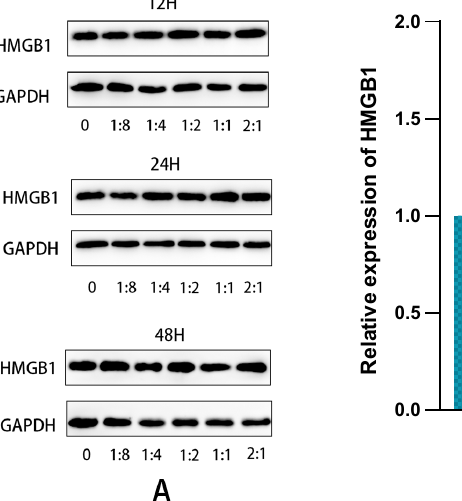
Figure 4. In the cell co-culture system, HSFs were stained with immunofluorescence. ( A ) The immunofluorescence staining of HMGB1 protein secreted by HSFs after cell co-culture for 24 h. Scale bar: 100 µ m. ( B ) The fluorescence intensity of HMGB1 protein secreted by HSFs after cell co-culture for 12 h, 24 h, and 48 h. ns: p > 0.05, *: p < 0.05, **: p < 0.01, ***: p < 0.001.